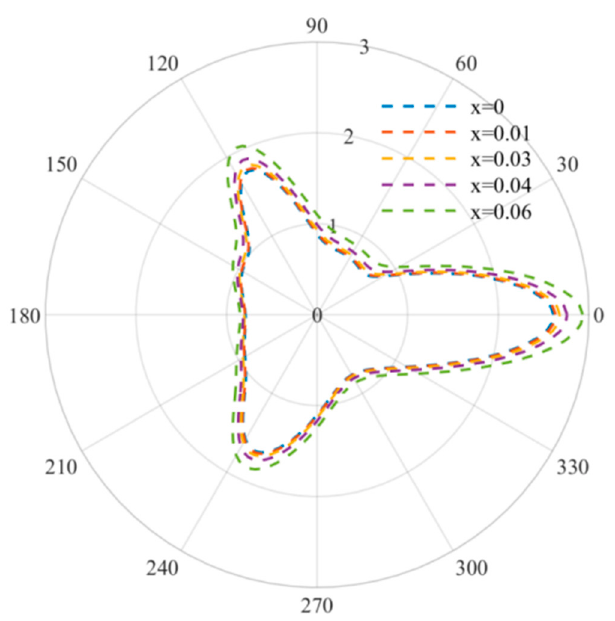
Figure 4. Distribution diagram of DSCD ( ka = 1).